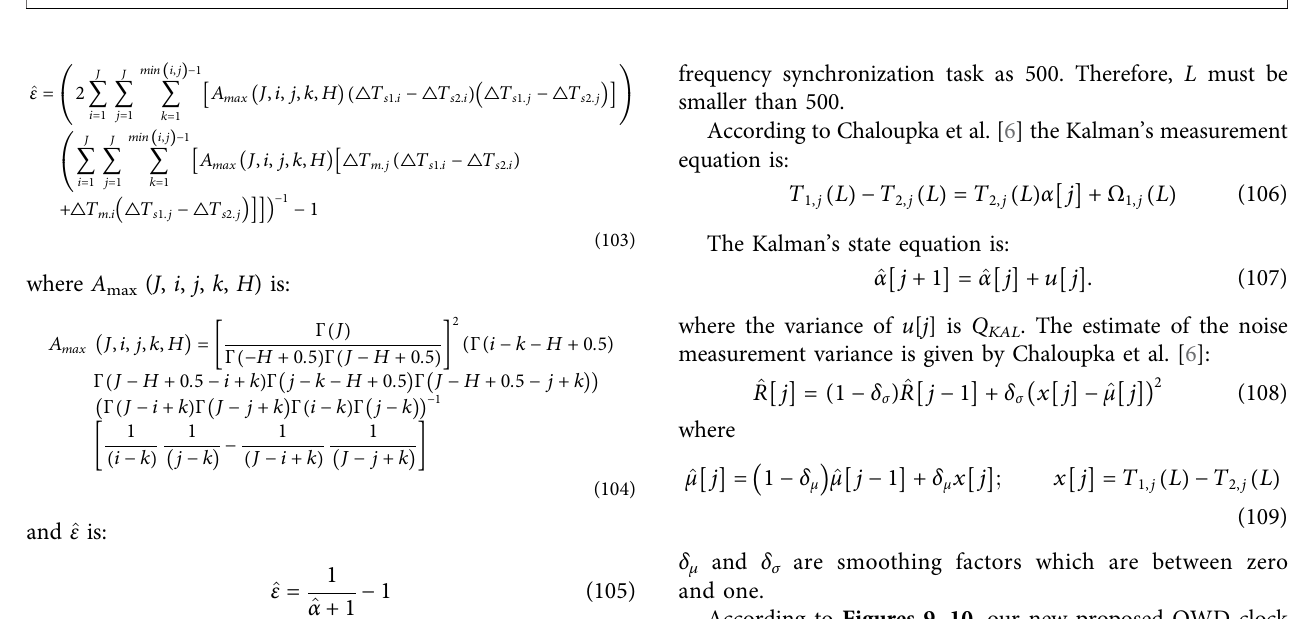
(cid:2) 0 . 8 e − 3 [ sec ] . Case2: Performance comparison forthegfGn case,betweenournew 1 ) , H = 0.95, a = 0.95, d ms = 5.5 ms , d sm = 5 ms . The results were obtained for 100 Monte-Carlo sec